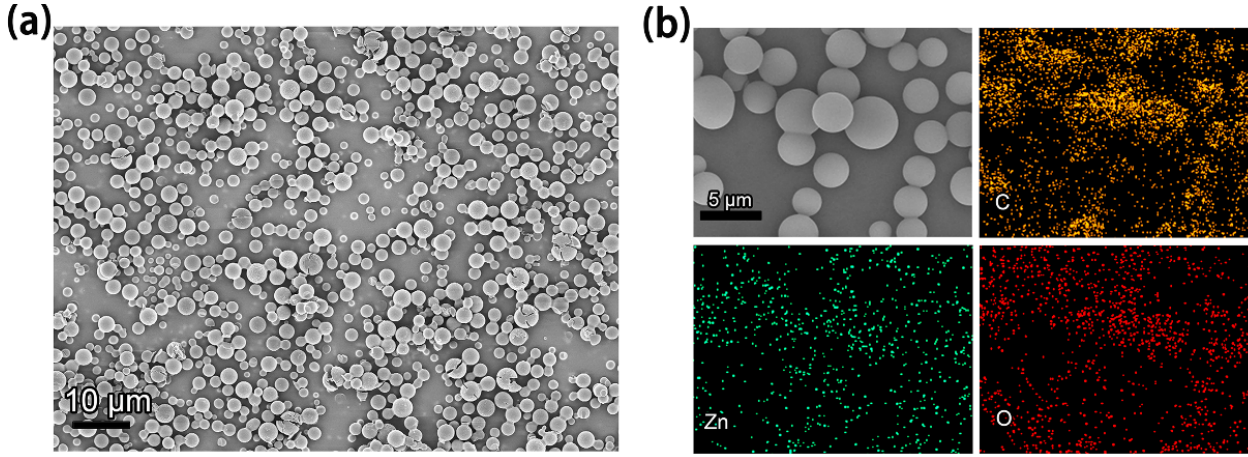
Figure 4. ( a ) The SEM image and ( b ) Elemental mapping of the Zn − Oxv thin fi lm. EC materials display dynamic optical − switching via electrical stimuli. The color of